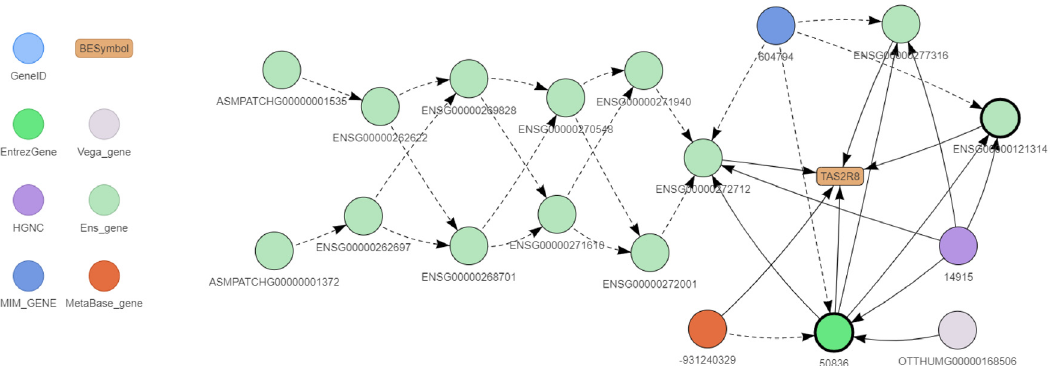
Figure 3. BED relationships between all the different identifiers of the human TAS2R8 gene recorded in the database. BEID are shown as circle and gene symbol in the rounded box. The color legend is shown to the left of the figure. BEID surrounded in bold correspond to preferred identifiers. Solid arrows represent correspond_to (between two nodes of identical shape) and is_known_as (between two nodes of different shapes) relationships. Dotted arrows represent is_replaced_by (between two nodes of identical color) and is_associated_to (between two nodes of different colors) relationships. This graph has been drawn with the exploreBe